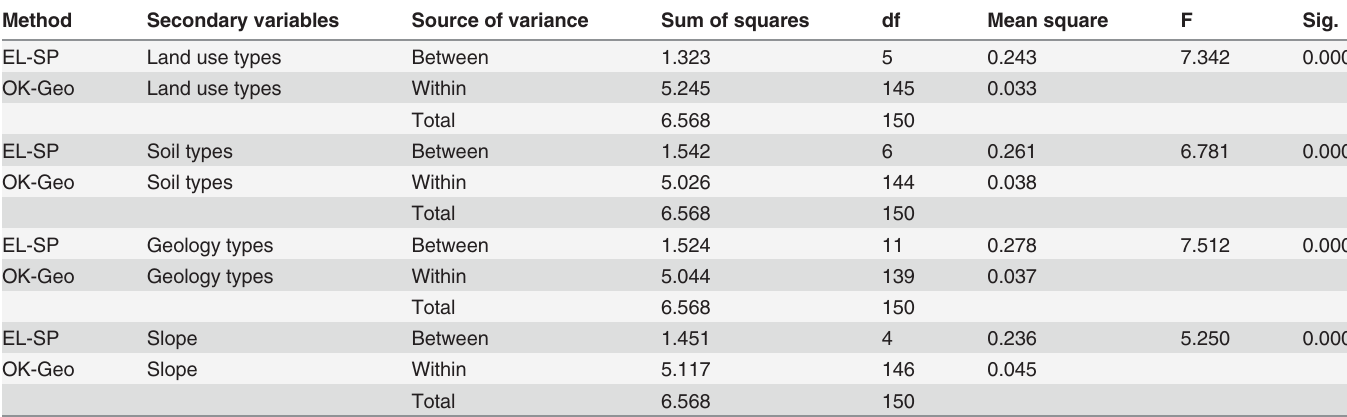
Table 1. The ANOVA results for testing the secondary variables effects on the variances of soil potassium content.